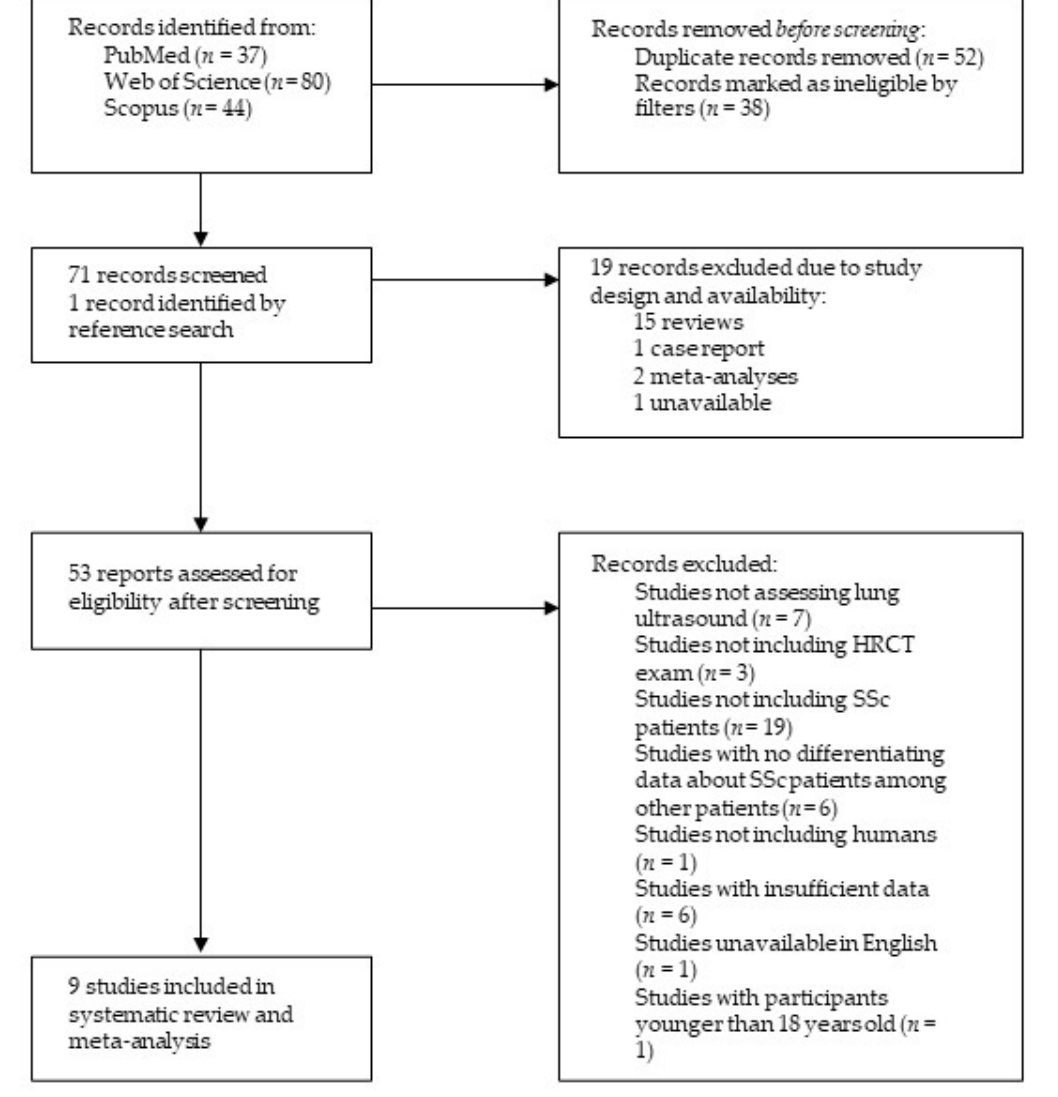
Figure 1. Structural outline of study selection process. Abbreviations: HRCT—high-resolution computed tomography, SSc—systemic Figure 1 . Structural outline of study selection process.